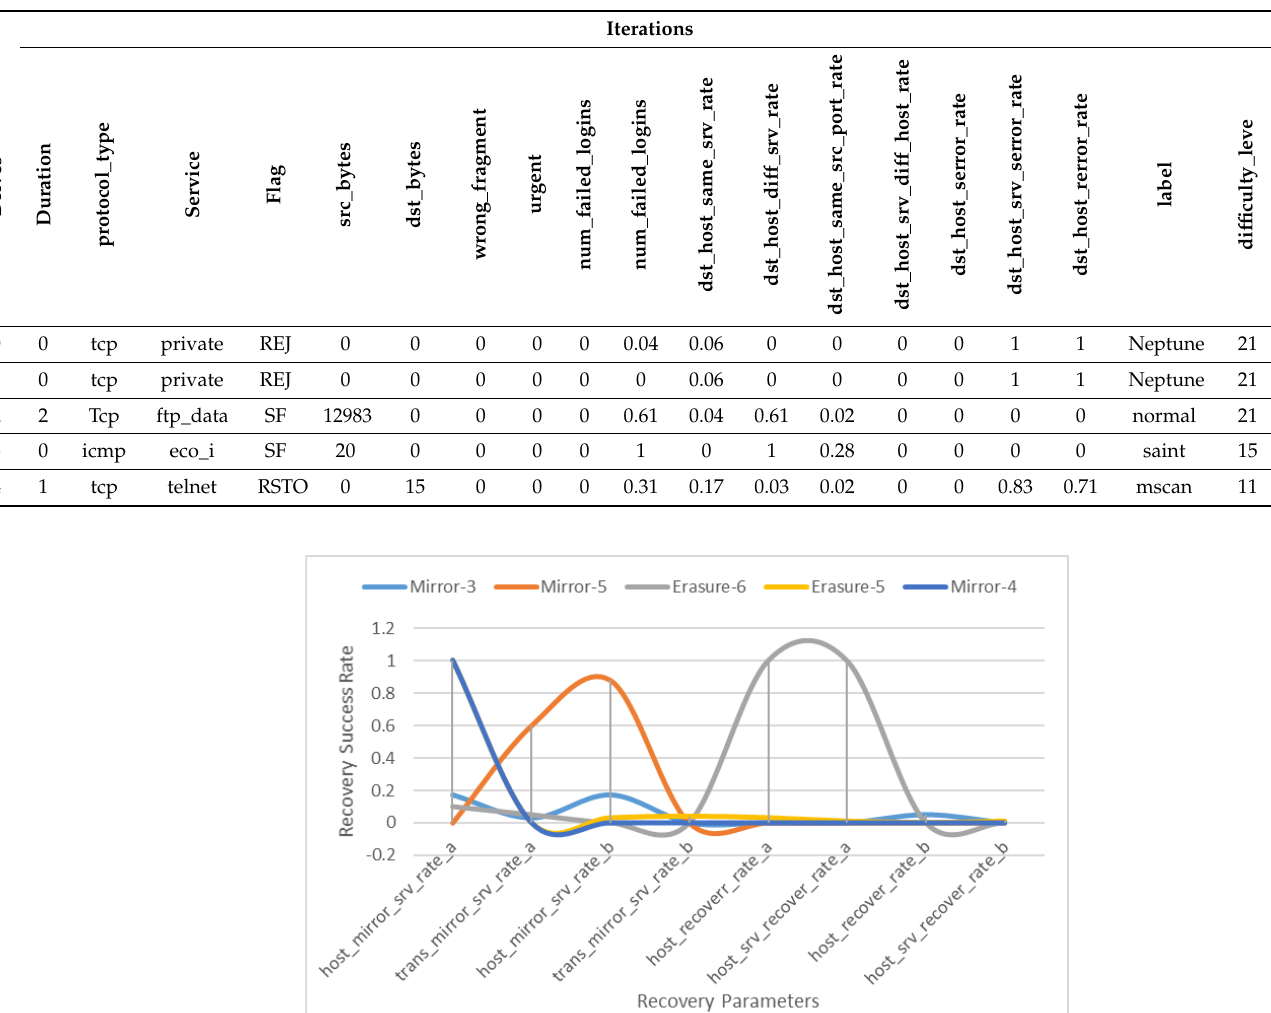
Table 6. Reference adjustment results.